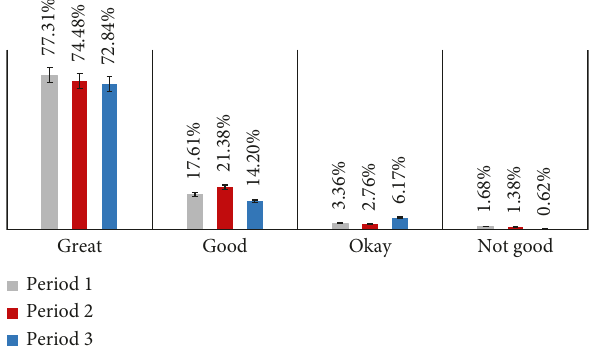
Figure 1: Overall satisfaction with medical care by period. Error bars represent standard error of those answering yes.